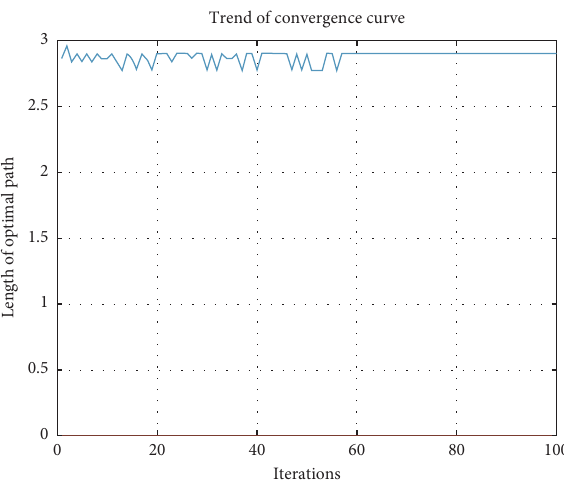
Figure 7: Te convergence curve of the ant colony